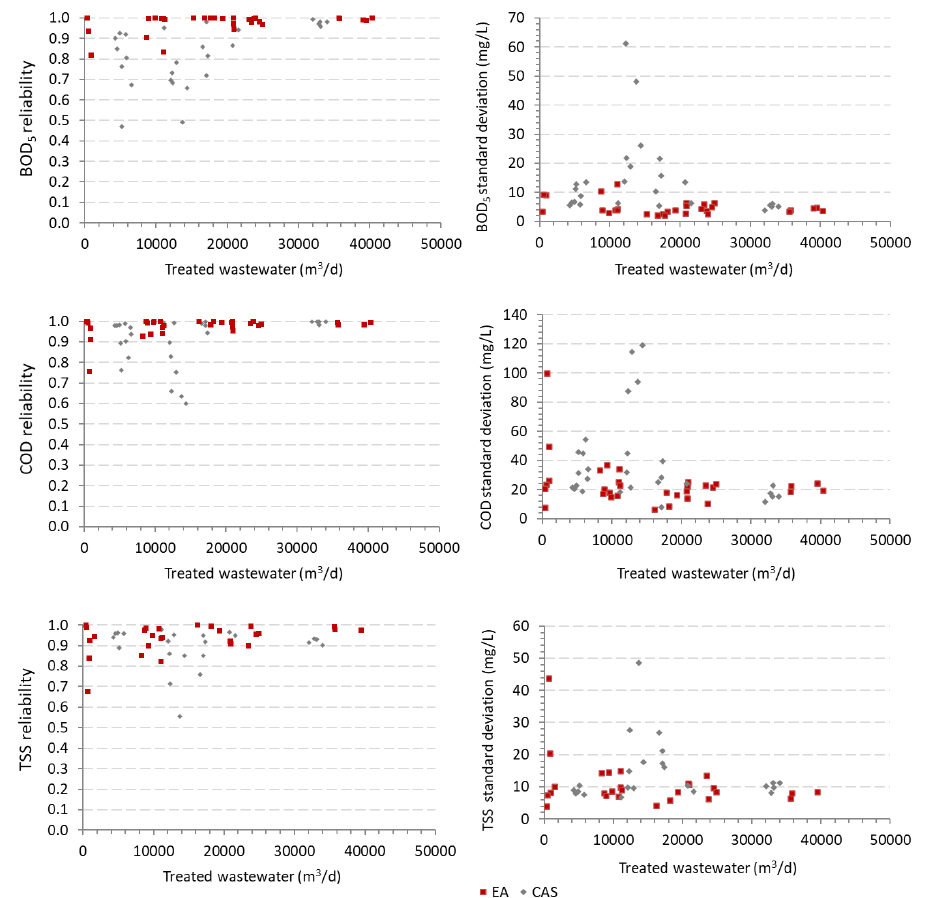
Figure 5. Plant annual reliability and standard deviation of BOD 5 , COD, and TSS effluent concentra- tions vs. treated wastewater (5-year data, 9 EA-WWTPs and 7 CAS-WWTPs).